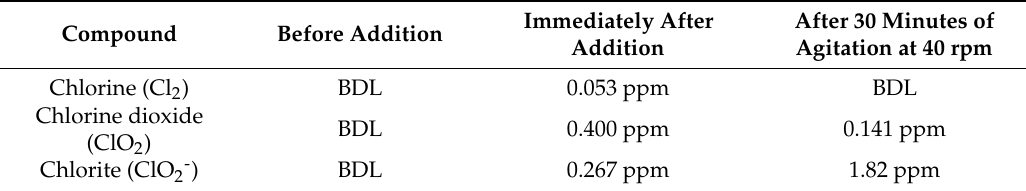
Table 19. Concentration of chlorine dioxide and the by-product, chlorite, in 1000 mL of seawater before and after addition of 0.40 ppm chlorine dioxide. Chlorine dioxide generated using chlorine and sodium chlorite (Equation (23)). Conditions: temperature = 27 ◦ C, pH = 7.81, conductivity = 42.4 mS / cm, turbidity = 1.93 NTU. Adapted from